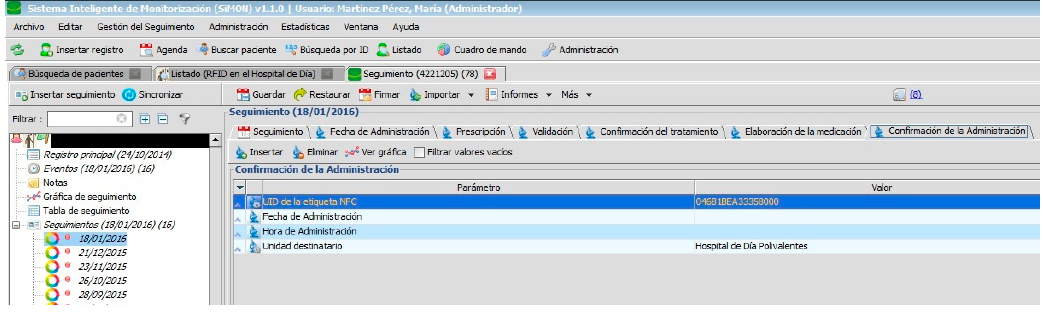
Figure 9. Confirmation of administration.